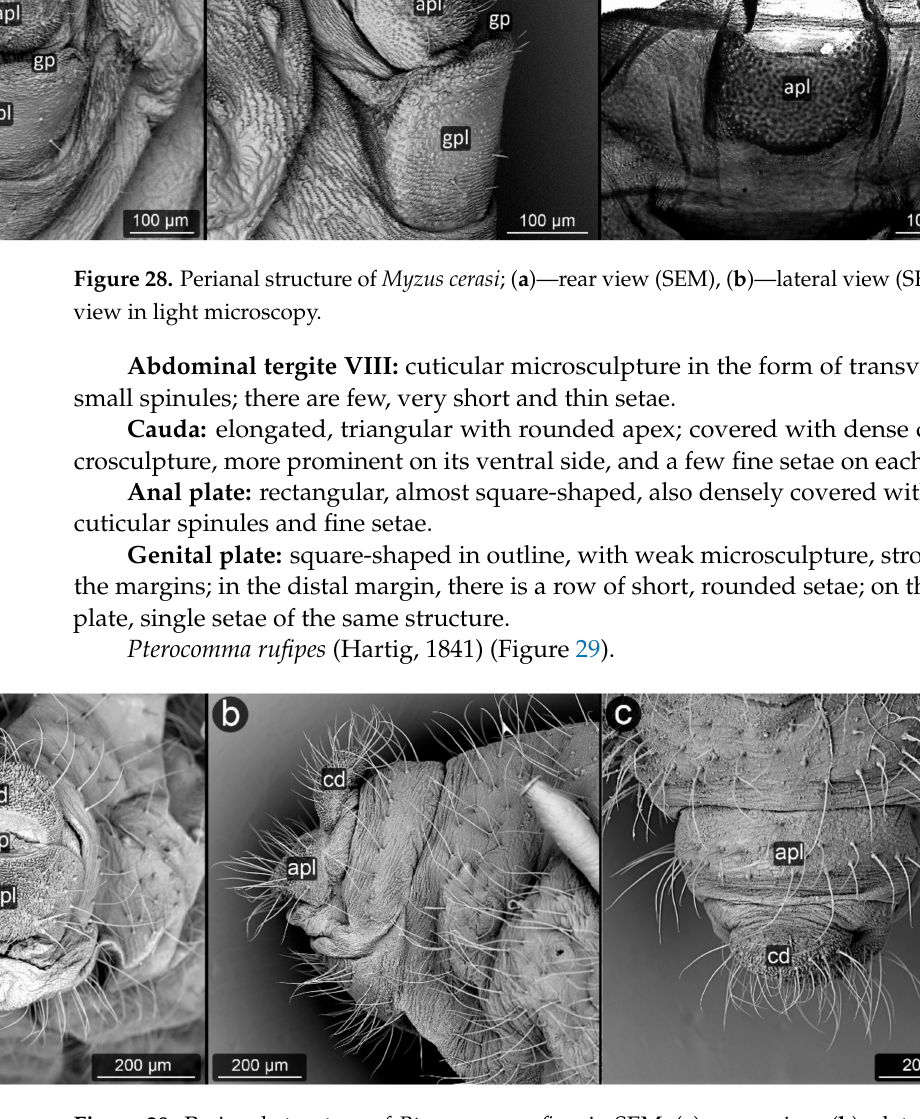
Figure 29. Perianal structure of Pterocomma rufipes in SEM; ( a )—rear view, ( b )—lateral view, ( c )— dorsal